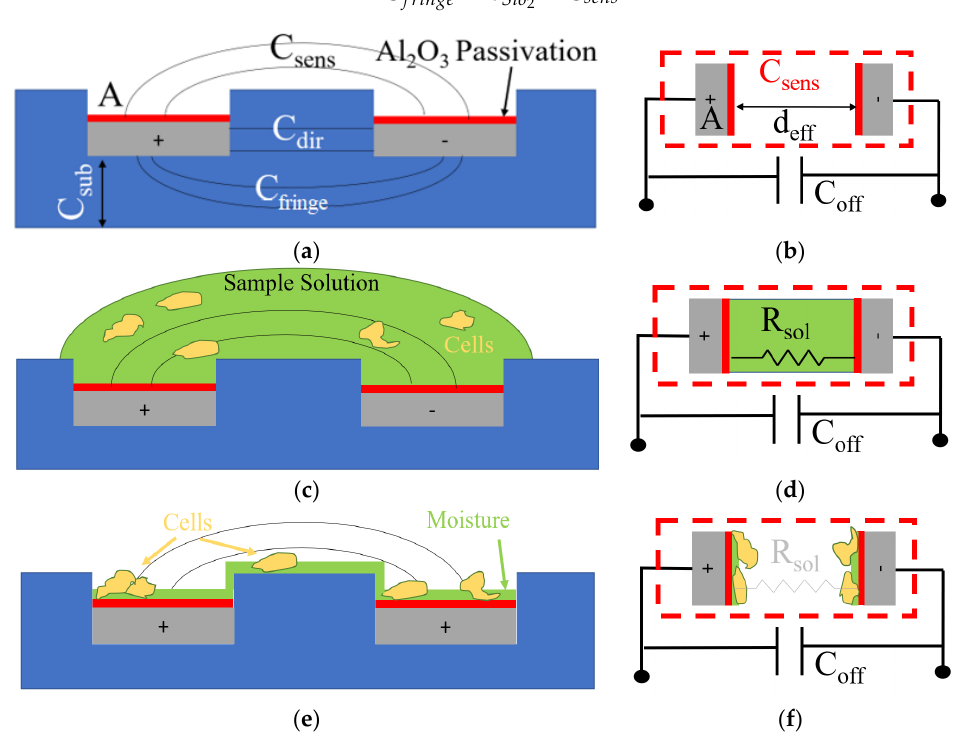
Figure 2. ( a ) Cross-section schematic of the implemented IDE electrode without sample; ( b ) Equivalent capacitance model without sample; ( c ) Cross-section schematic of the IDE electrode with the sample before the evaporation of the sample solution; ( d ) Equivalent capacitance model of the sample before the evaporation of the sample solution; ( e ) Cross-section schematic of the IDE electrode with the sample after the evaporation of the sample solution; ( f ) Equivalent capacitance model of the sample after the evaporation of the sample solution.